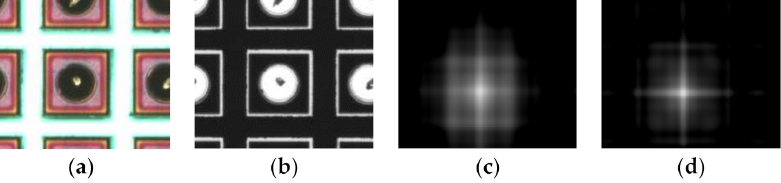
Figure 7. Modified NCC matching result: ( a ) color area to be matched; ( b ) coaxial area to be matched; ( c ) color area matching result; ( d ) coaxial area matching